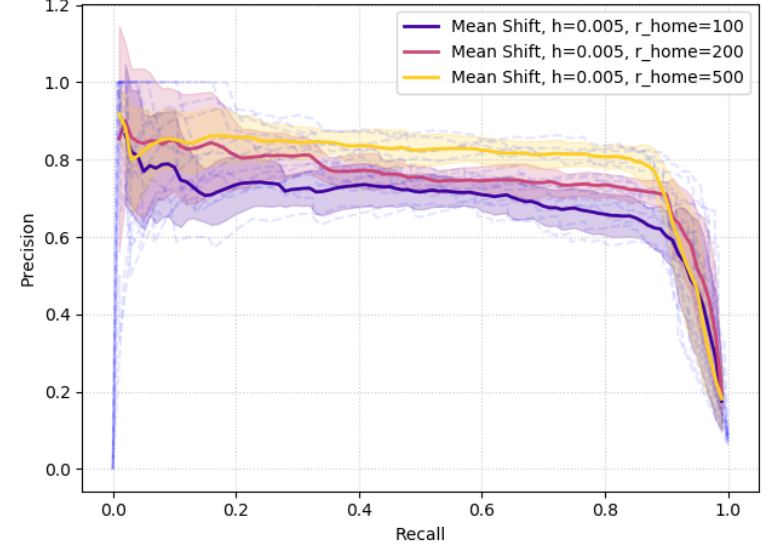
Figure 5. Comparison of the performance of the prediction for different values of the home distance tolerance, r home